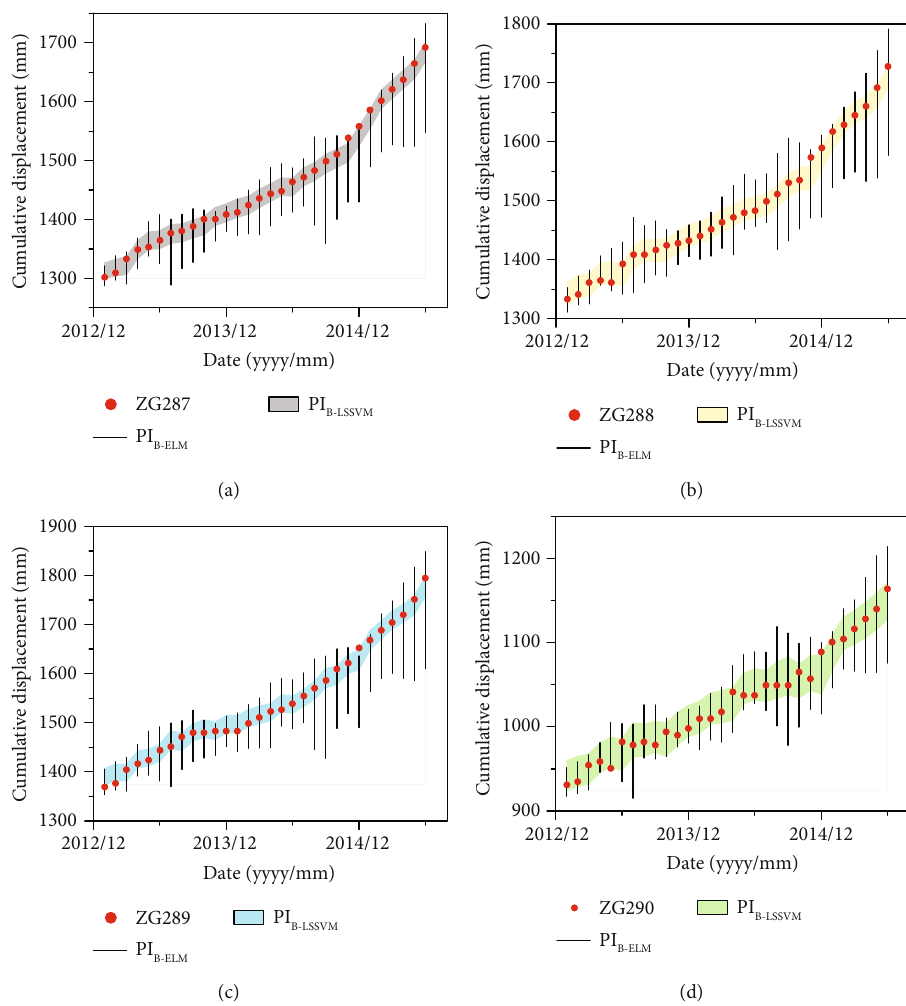
Figure 6: Optimal PIs of the displacement of four monitoring points with a 95% con fi dence level using the B-LSSVM and B-ELM methods (PI denotes the PI constructed using the B-ELM method and PI B-ELM